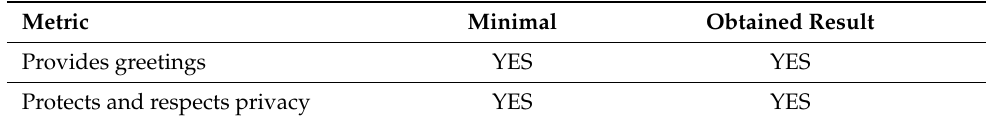
Table 6. Summary of humanity evaluation. Metric Minimal Obtained Result Provides